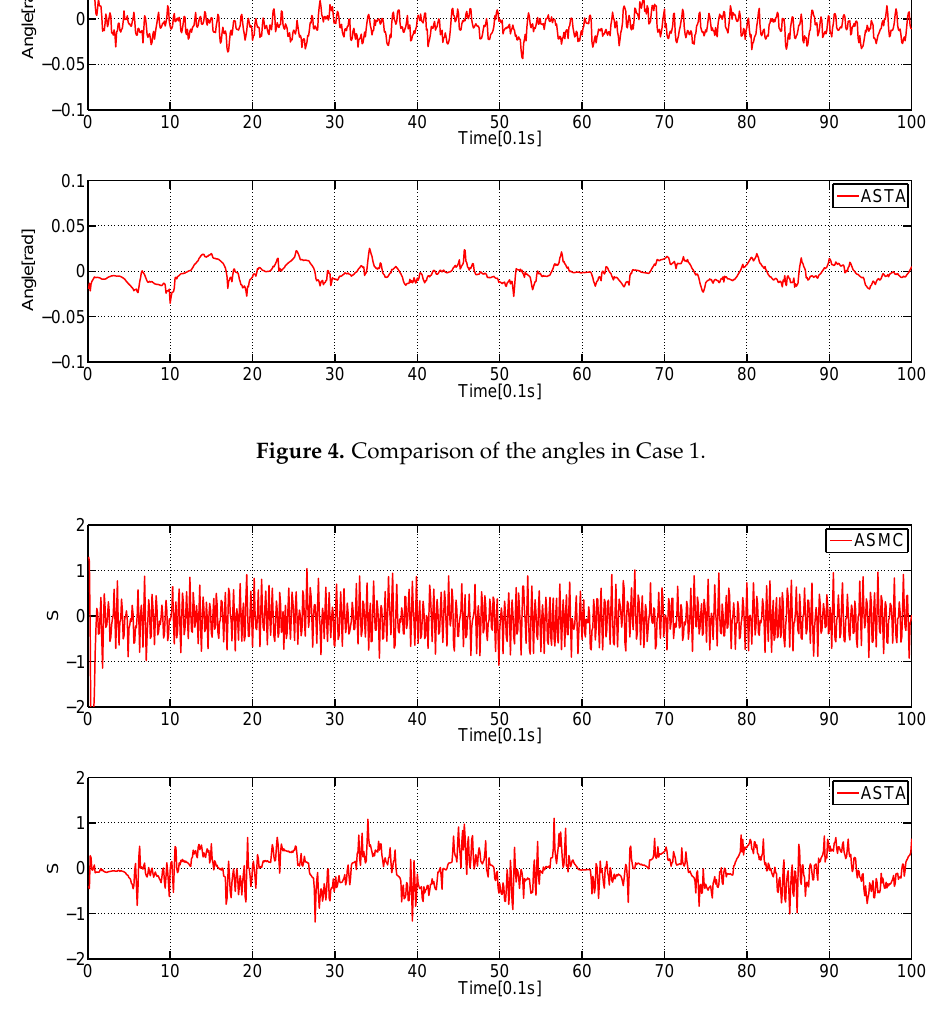
Figure 5. Comparison of the sliding mode variables in Case